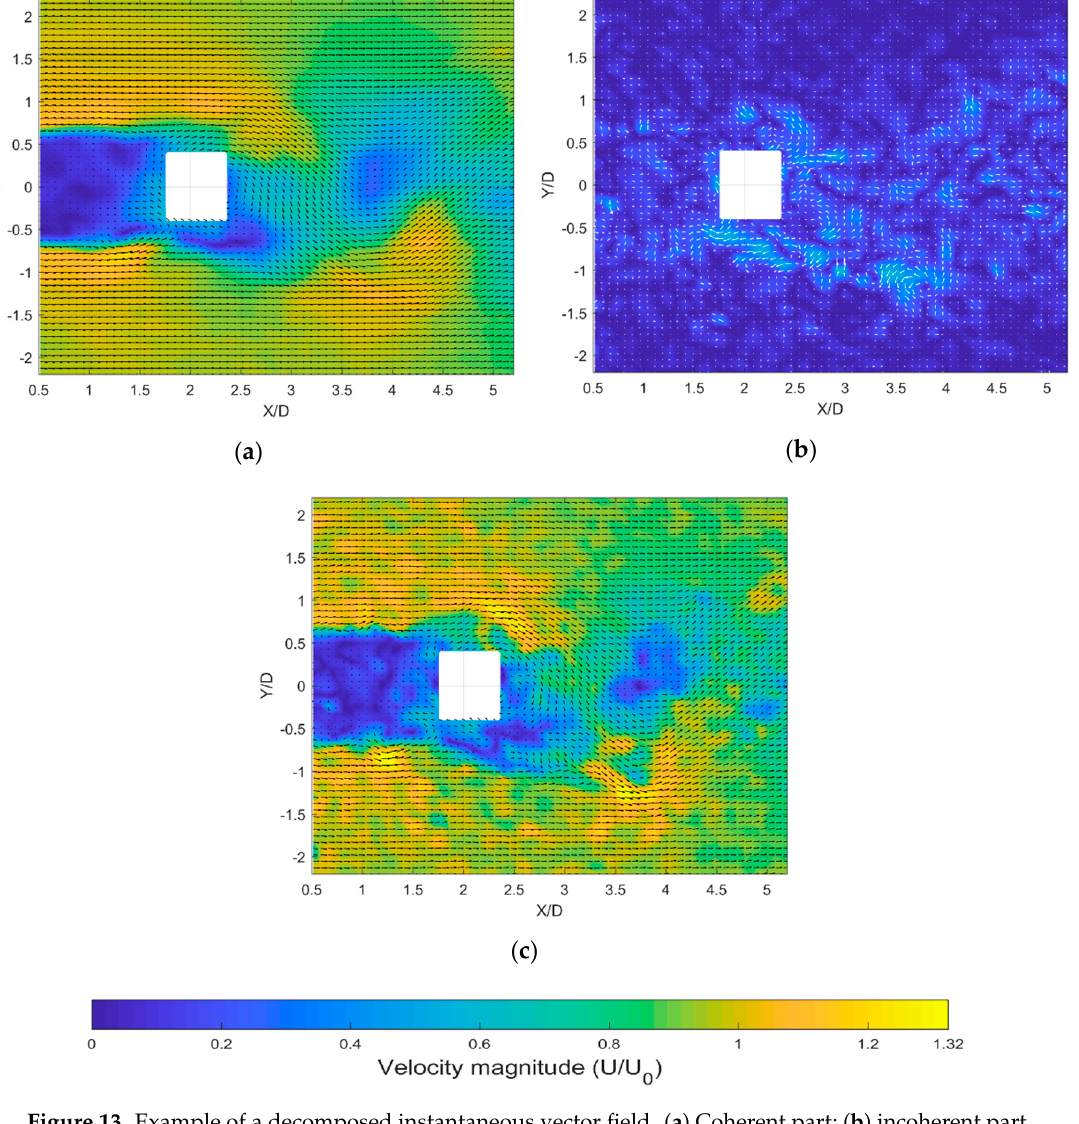
Figure 13. Example of a decomposed instantaneous vector field. ( a ) Coherent part; ( b ) incoherent part (vectors shown white for clarity); ( c ) raw velocity field. Colour scale represents velocity magnitude normalized with free-stream velocity, U 0 .